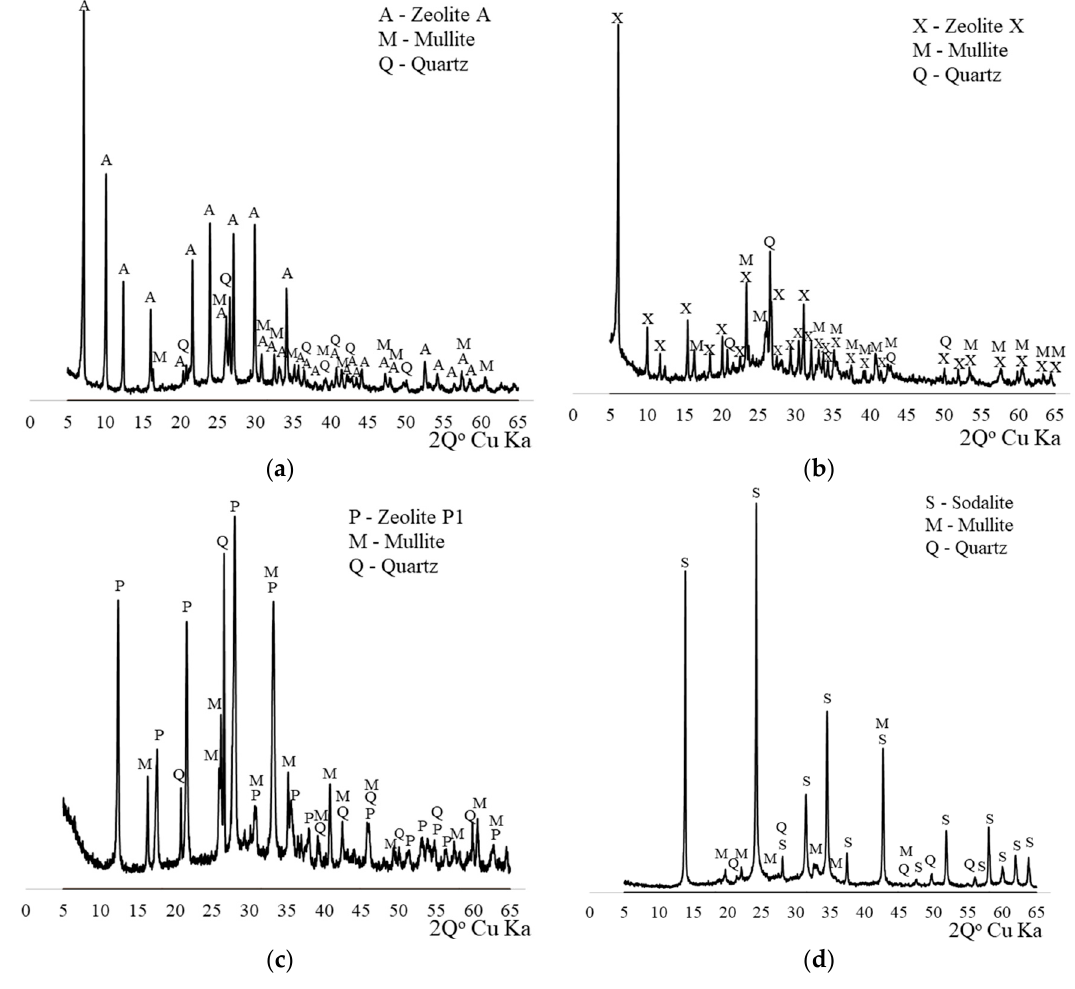
Figure 1. Diffractograms of mineral composition for zeolite materials used in research: ( a ) NaA; ( b ) NaX; ( c ) NaP1; ( d ) sodalite.